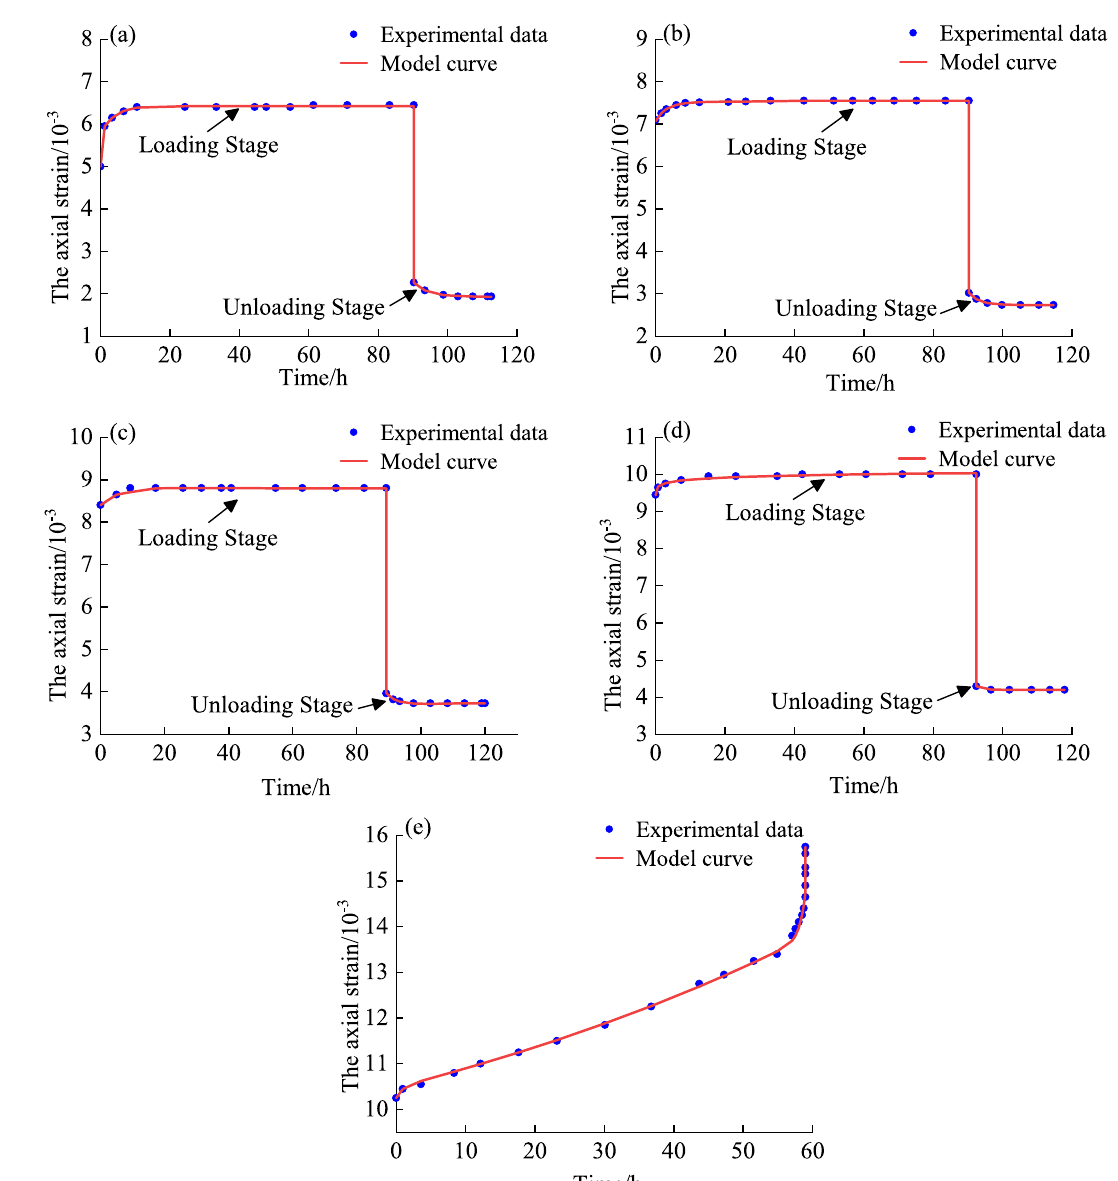
Figure 4. Comparative analysis of model curve and test data when the confining pressure is 4 MPa. (a) 11.99 MPa, (b) 14.99 MPa, (c) 17.99 MPa, (d) 20.97 MPa, (e) 23.98